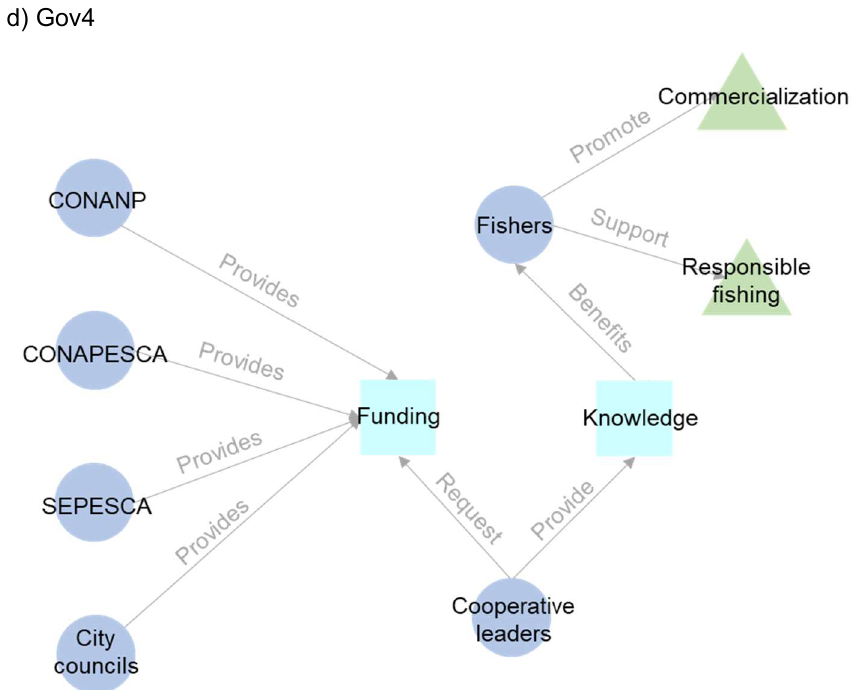
Fig. A3.4. Individual mental models of four government agencies’